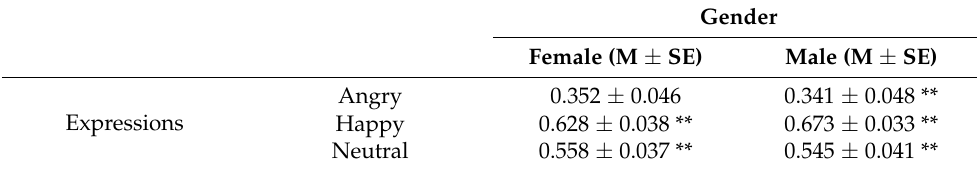
Table 1. Mean investment rates of different conditions.